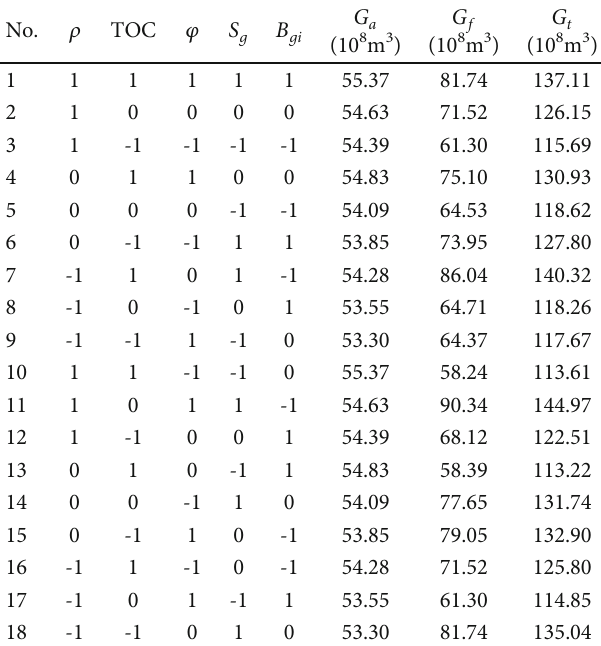
Table 2: The calculation results of shale gas reserves of 18 tests.